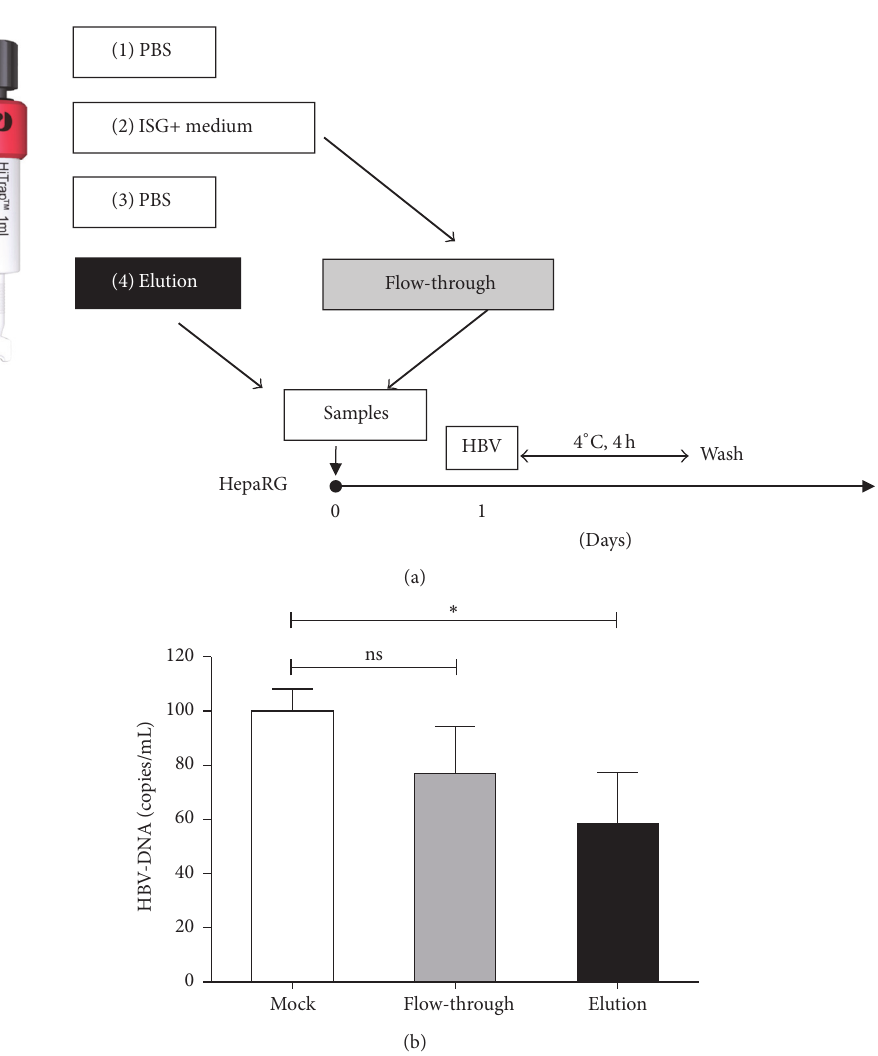
Figure 5: IFN- 𝛼 induced products inhibit HBV binding to the cells. (a) Heparin columns were washed with PBS and then applied with IFN- 𝛼 treated differentiated HepaRG cell culture medium. Then columns were washed with PBS. Differentiated HepaRG cells were incubated with elution or flow-through for 24 hours followed by 4 hours of HBV incubation at 4 ∘ C. (b) Cells were lysed and cellular HBV-DNA were evaluated by qPCR. Data are means ± s.d. ∗ 𝑃 < 0.05 , ∗∗ 𝑃 < 0.01 , and ∗∗∗ 𝑃 < 0.001 by Student’s unpaired two-tailed 𝑡